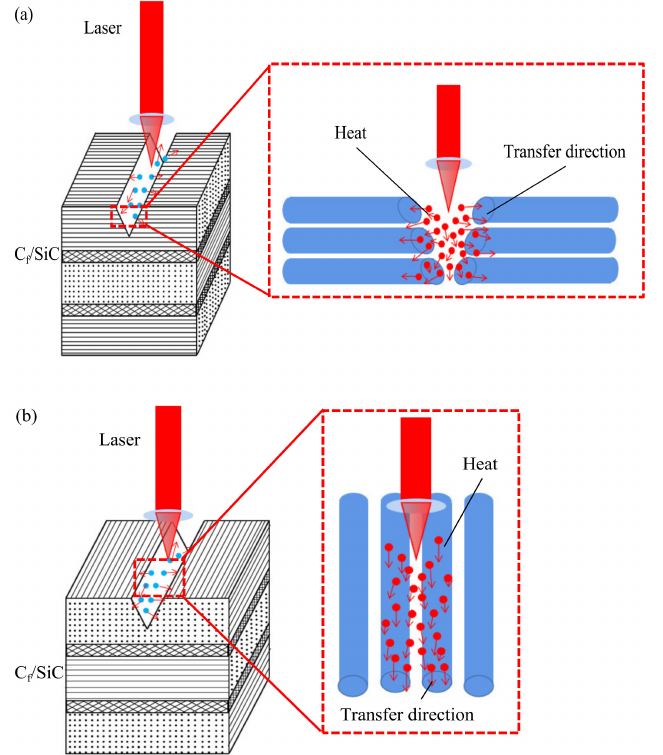
Figure 8. The heat transfer affected by the anisotropy structure (( a ). perpendicular to fiber direction; ( b ). parallel to fiber